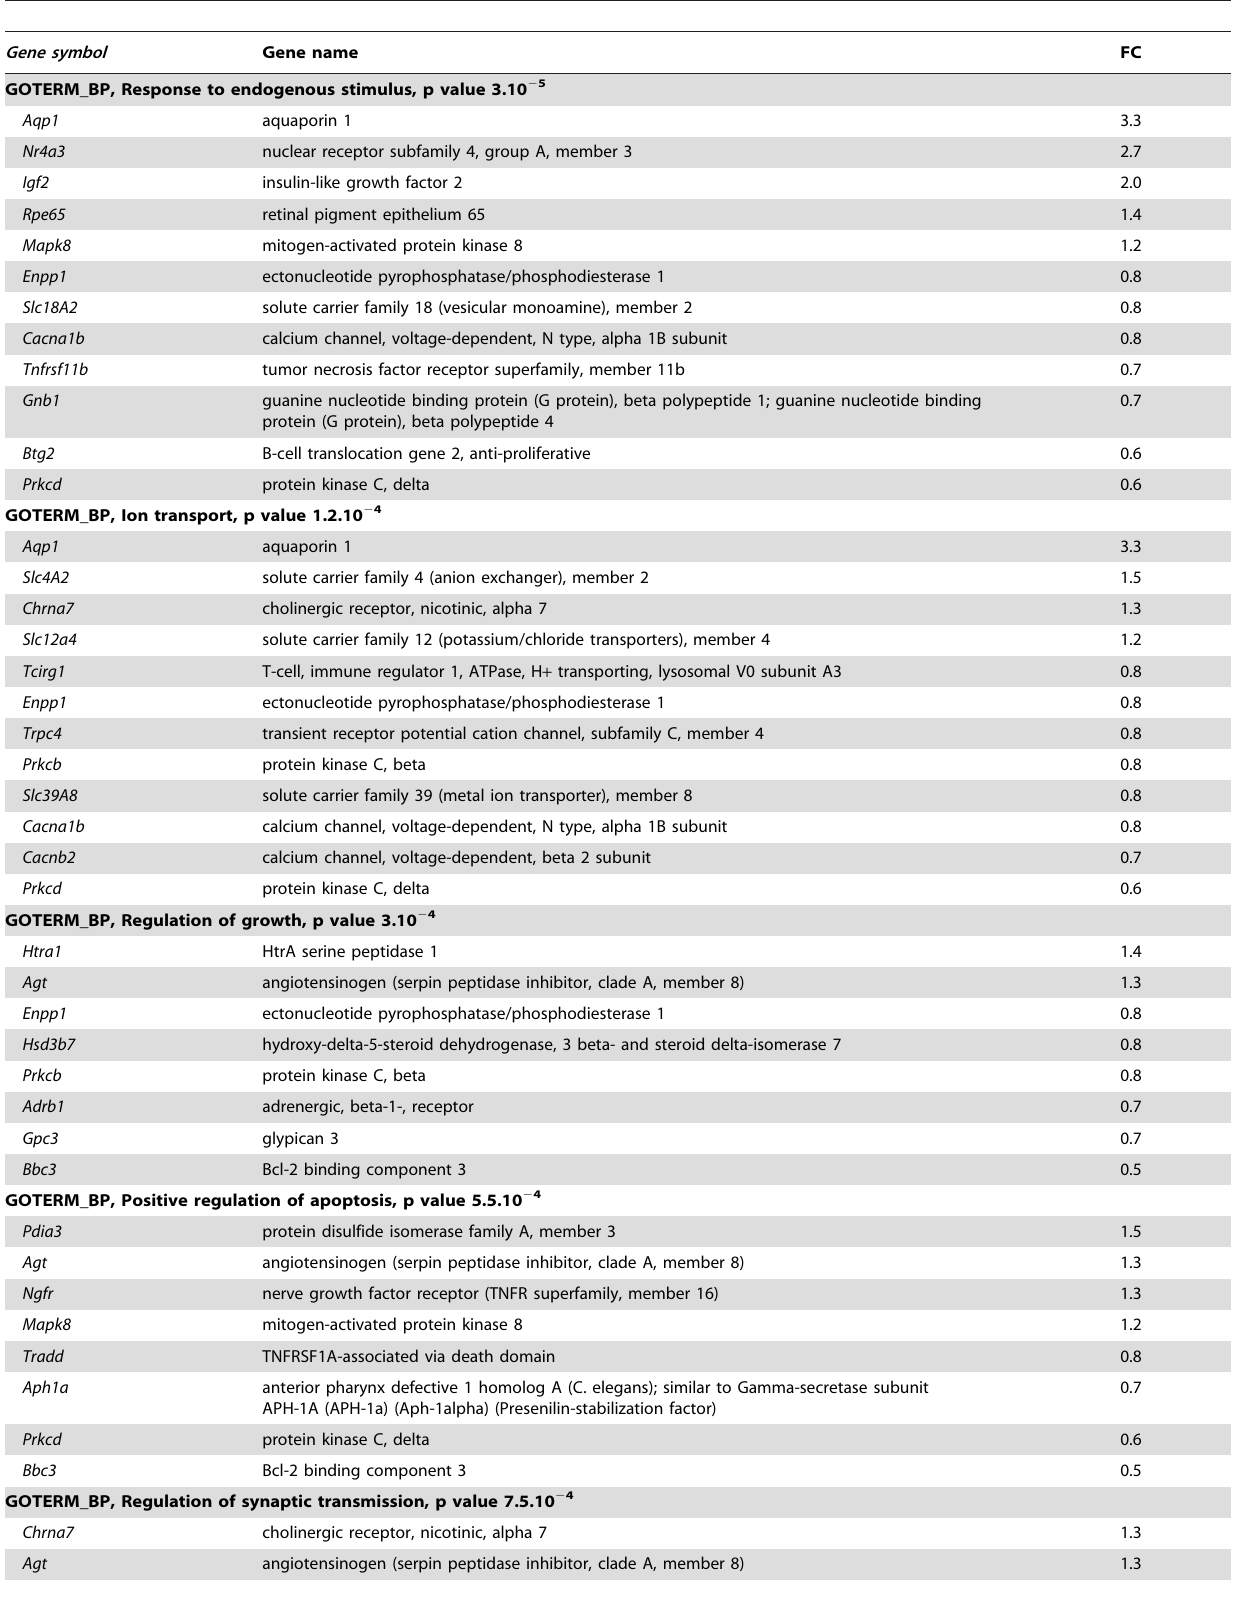
Table 1. Enriched functional categories (GO terms) for genes differentially expressed after HFS vs 6-OHDA, with the constituting genes and their fold change